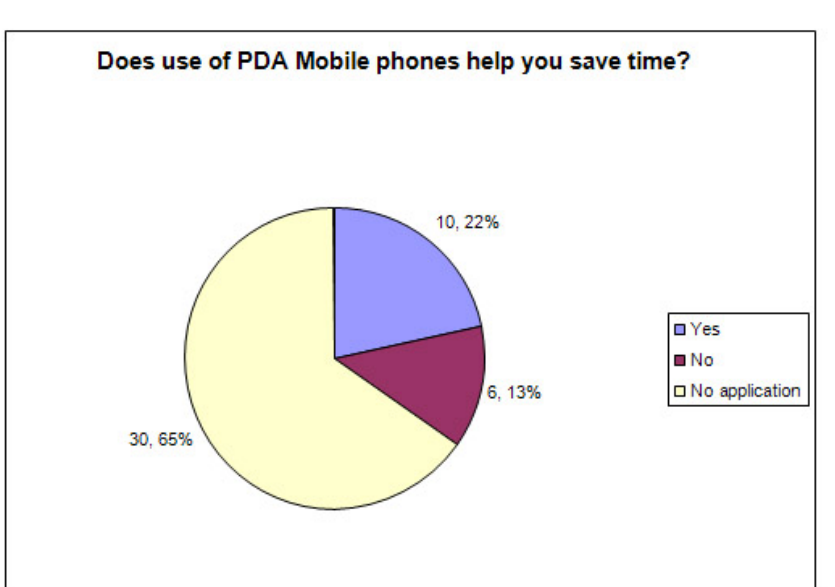
Figure 4. Mobile learning outcomes